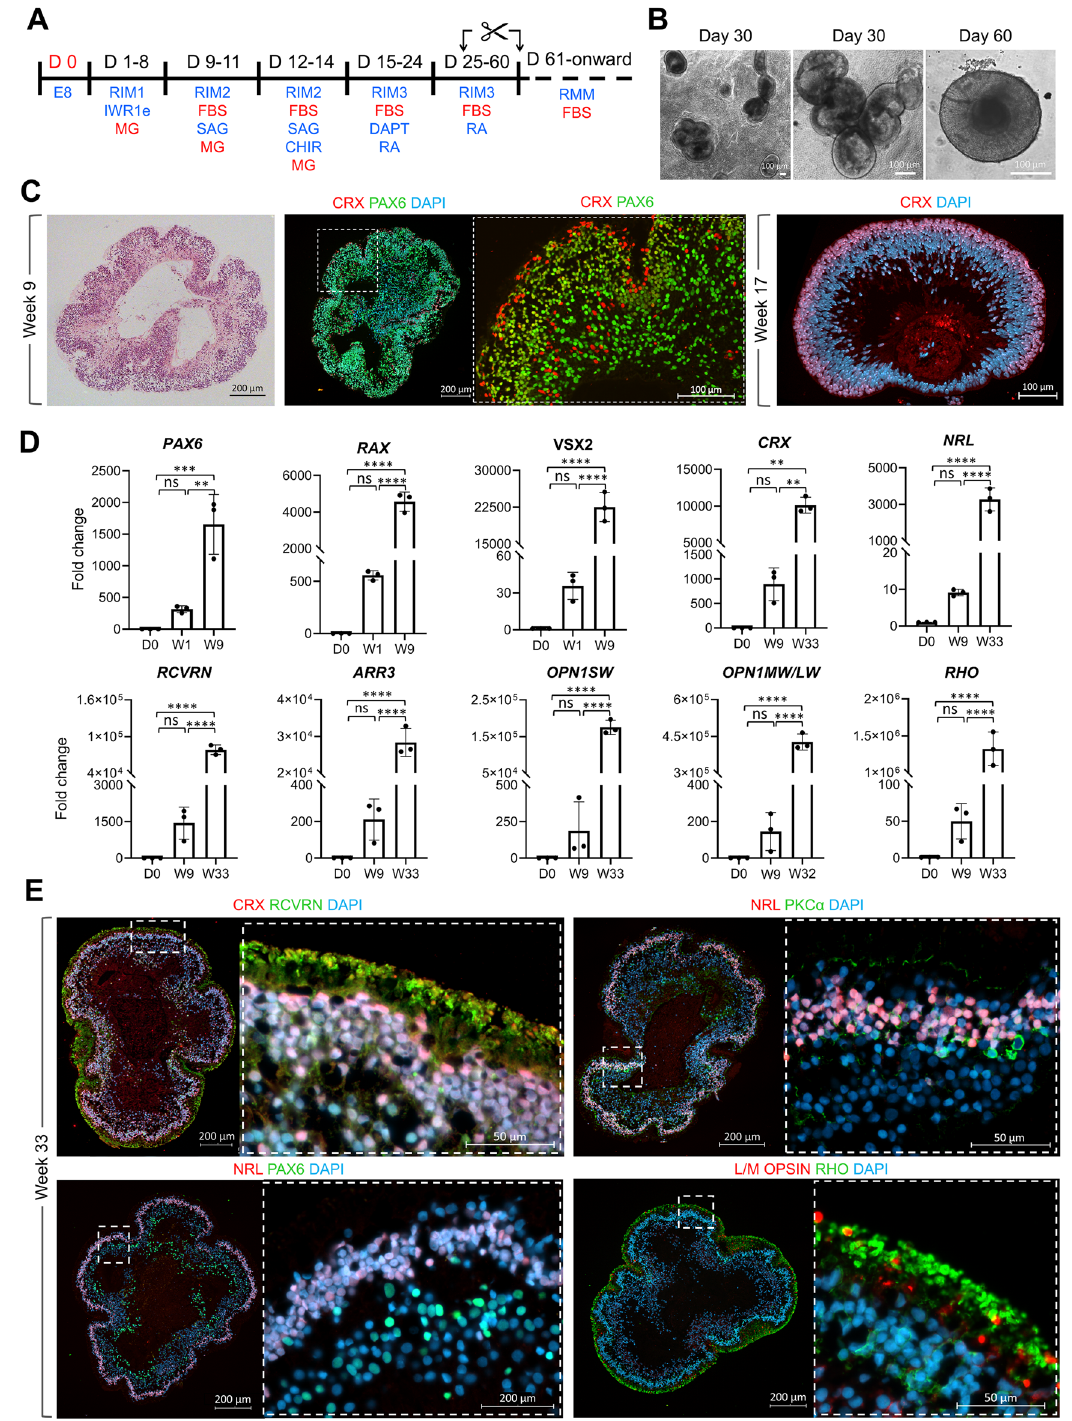
Figure 1. 2D/3D small molecule-based differentiation of hPSC into retinal organoids using animal-derived supplements (xeno). ( A ) Schematic of the 2D/3D xeno small molecule protocol ( B ) Bright-field microscopy of 3D optic vesicle-like structures at day 30 and manually picked organoid at day 60 of differentiation (MShef10; scale bars 100 µm) ( C ) Immunohistochemistry analysis of retinal organoids at week 9 and 17 of differentiation, (MShef4 and MShef10 ESC lines respectively). ( D ) RT PCR analysis of relative expression of retinal marker genes (mean ± SD; n = 3 independently cultured sets of 10 OVs from N = 1 ESC line, MShef4). ( E